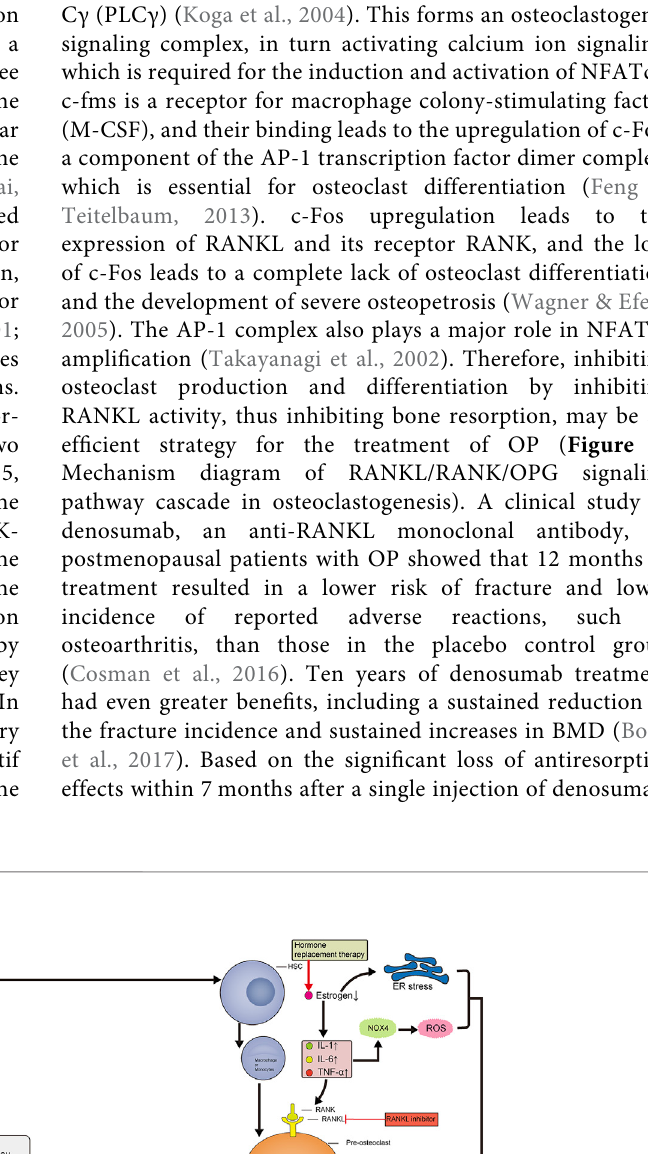
ef fi cient strategy for the treatment of OP ( Figure 4 : Mechanism diagram of RANKL/RANK/OPG signaling